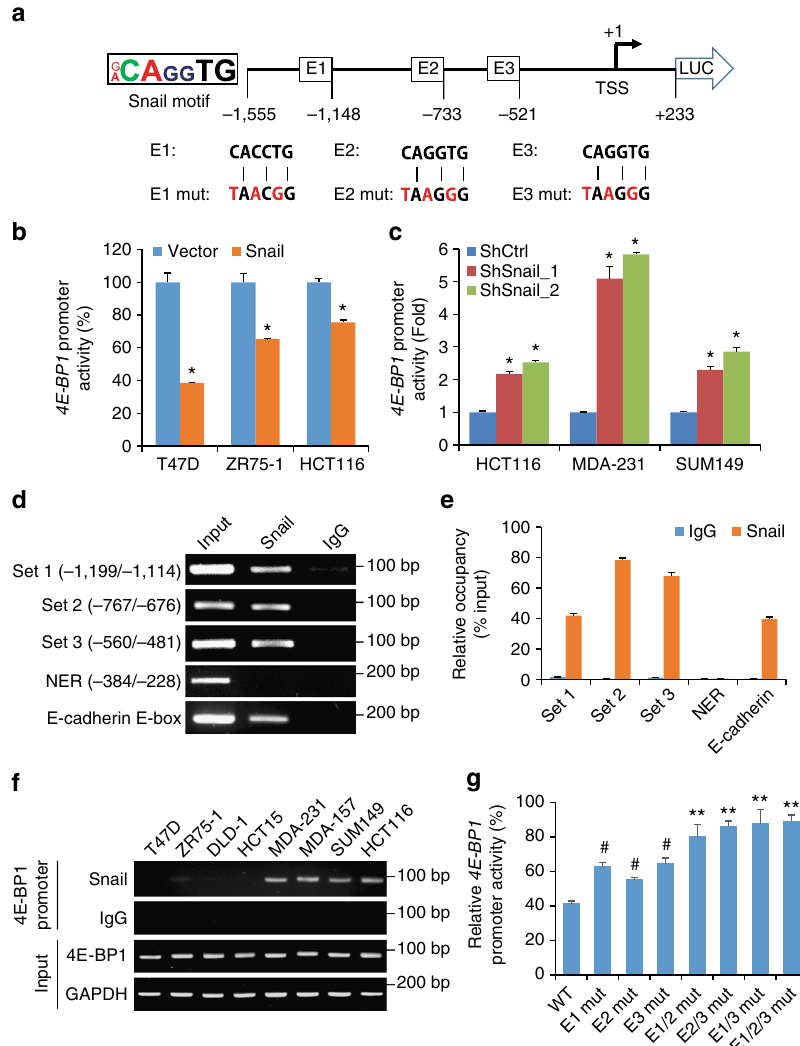
Fig. 3 Snail represses 4E-BP1 promoter activity. a Schematic diagram of the human 4E-BP1 promoter- fi re fl y luciferase construct (4E-BP1-Luc) showing positions of the three potential Snail-binding E-boxes (E1, E2, and E3). Mutated (Mut) nucleotides in each E-box sequence are indicated with red characters. b , c The indicated cell lines with expression b or knockdown c of Snail or their respective controls were co-transfected with human 4E-BP1-Luc and an internal control Renilla -Luc. After 36 h, luciferase activities were measured and normalized. The results are expressed as a percentage of the activity found in vector control cells b or as a fold increase over the Luc activity found in shRNA control (ShCtrl) cells c . d ChIP analysis of Snail-expressing HEK293 cell extracts using a speci fi c antibody against Snail or an irrelevant IgG. Four sets of primers cover E1, E2, and E3 boxes and non-E-box region (NER) on the 4E-BP1 promoter, and a set of primers covers an E-box of the E-cadherin promoter as a positive control. e Enrichment levels for Snail or an irrelevant IgG at four regions of 4E-BP1 promoter and an E-box region of E-cadherin promoter as shown in d are presented as a percentage of input. f ChIP analysis of DNA from different cell lines using a speci fi c antibody against Snail and the set 3 primers described in d . g Snail-expressing or vector control T47D cells were co- transfected with pGL3-4E-BP1-Luc (WT, wild type) or the same plasmid containing mutations in different E-boxes together with an internal control Renilla - Luc. Data are expressed as Luc activity in the presence of exogenous Snail as a percentage of the activity of the same reporter in vector control cells. All graphic data are presented as mean ± SEM ( n = 3 technical replicates per condition). * P < 0.001 for Snail vs. vector or ShSnail vs. ShCtrl; # P < 0.001 for each mutated E-box vs. WT; ** P < 0.02 for the combination of mutated E-boxes vs. WT or each mutated E-box. Statistical signi fi cance was determine